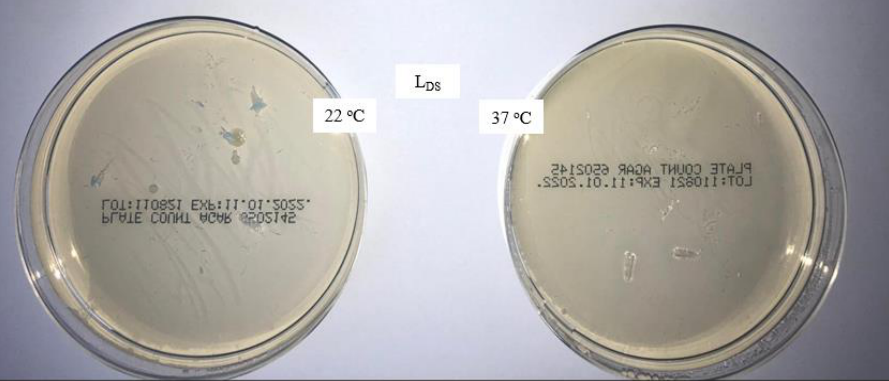
Figure 4. Colonies of aerobic microorganisms on a medical mask after laboratory washing with the addition of DDAC (L DS 5 × ).